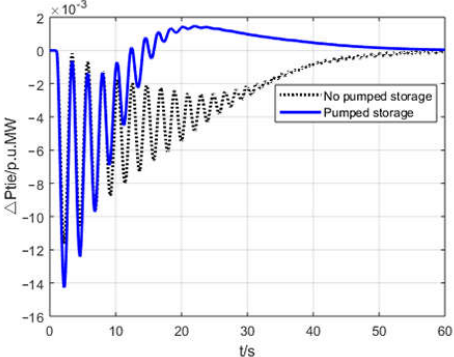
Figure 9. (cid:52) P tie variation chart at generating operation Figure 9. △ P tie variation chart at generating operation mode. Figure 9. △ P tie variation chart at generating operation mode.